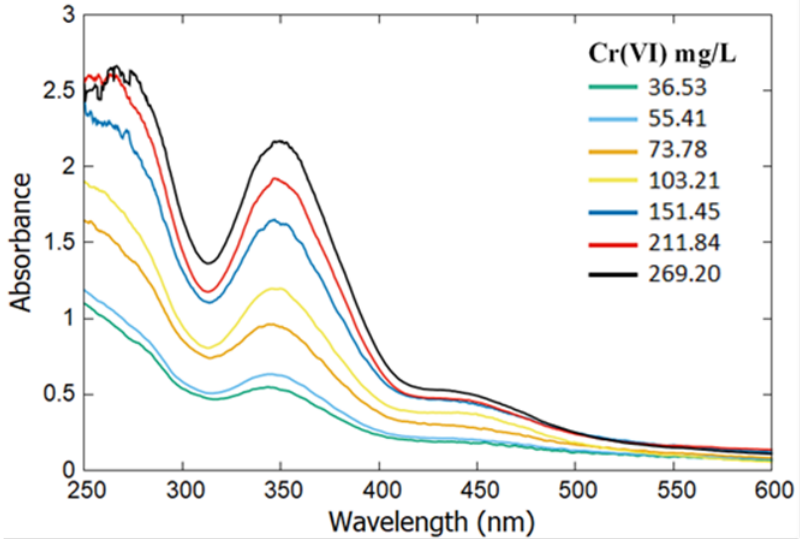
Figure 8. ( a ) Langmuir isotherm and ( b ) Freundlich isotherm plots. Table 4. Equilibrium data and correlation factor of Freundlich isotherm model.